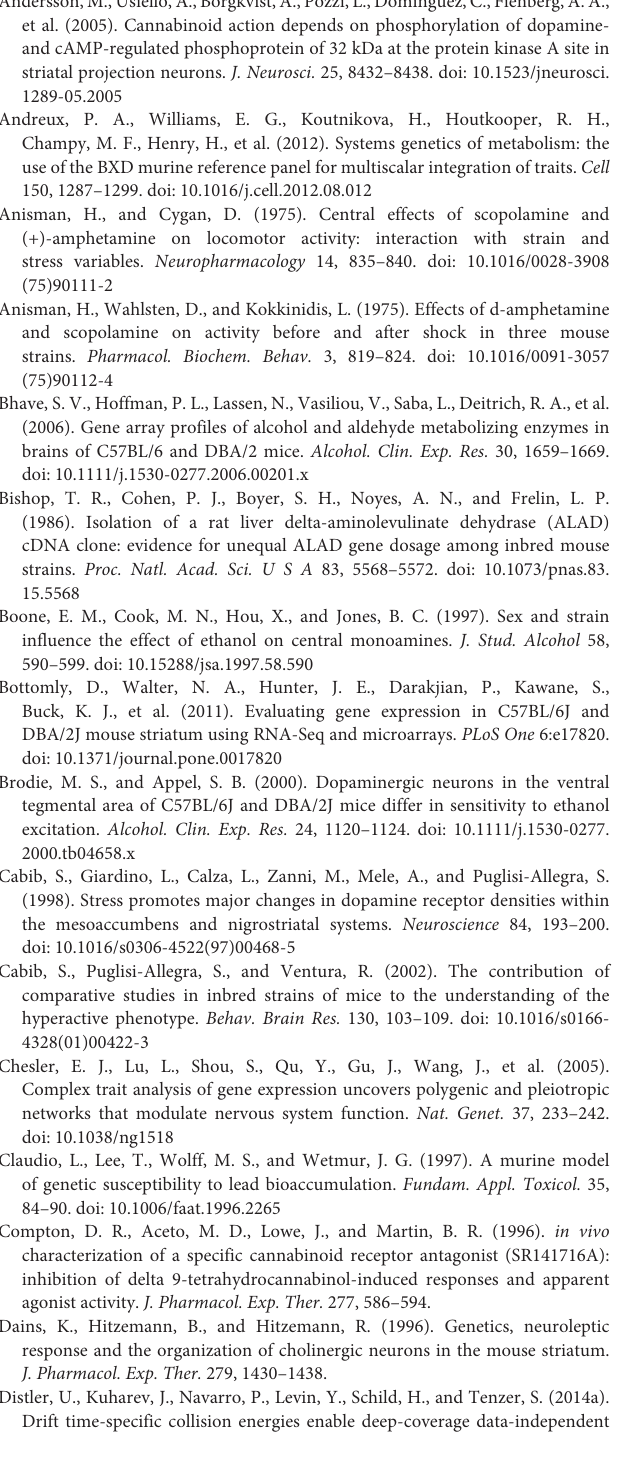
TABLE S4 | DE protein Regulation by cis expression quantitative trait loci (cis